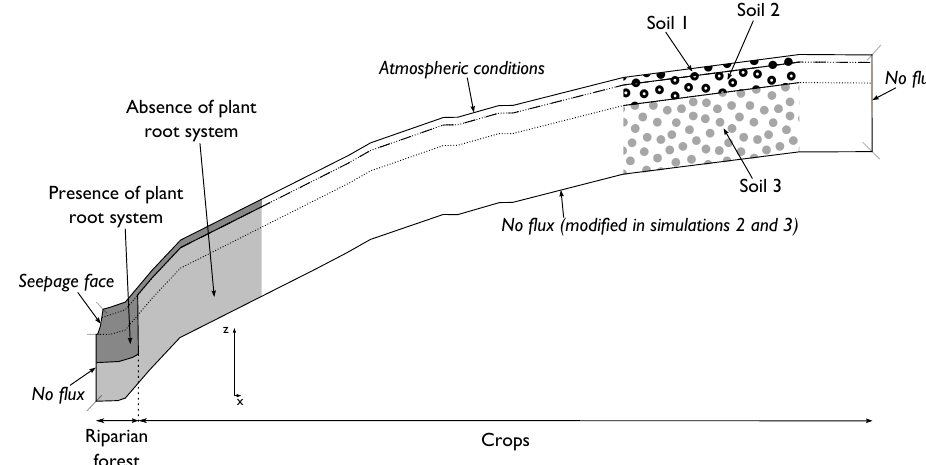
Fig. 4. Schematic of the plant root system distribution and of the soil distribution with indication of the boundary conditions. Left, plant root system distribution. Dark grey corresponds to the region where b 0 = 1, light grey corresponds to the region where b 0 = 0. The vertical dashed line shows the lateral extent of the tree root system, fitted to 30m (5% of the hillslope length), while the long dashed lines show the continuation of the plant root system distribution upslope. Right, schematic of the 3-layer soil distribution with dotted lines showing its continuation upslope and downslope. Boundary conditions are indicated in italics. Short grey segments separate different boundary conditions. Vertical stretching: 10. Table 2. Soil physical parameters used in the van Genuchten–Mualem model for the three soil layers. θ r : residual water content; θ s : saturated water content; h g : inflection point pressure; n : pore size distribution parameter; Ks: saturated hydraulic conductivity; L : pore conductivity